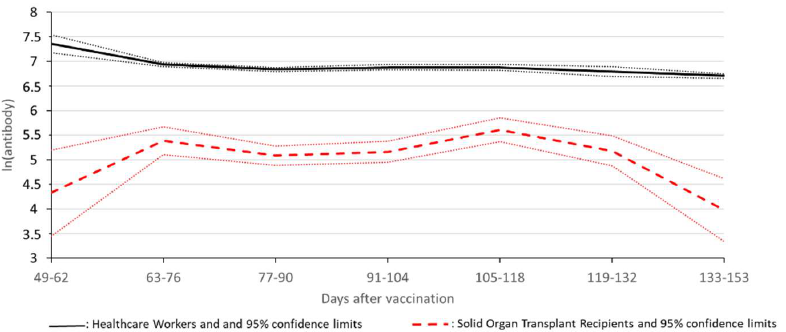
Figure 1. Mean ln (RBD) and 95% confidence limits in HCWs (continuous line) and SOT recipients (broken line) between 49 and 153 days after vaccination, adjusted for sex and age. The mean ln (AbR) in the two populations for the periods between 49 and 153 days after vaccination in individuals with positive AbR. The ratio of ln (AbR) between HCWs and SOT recipients ranged between 1.2 and 1.7, i.e., between 3.3 and 5.5 on arithmetic scale; SOT recipients showed a significant increase up to 76 days ( p < 0.001), then a non-significant decrease in ln (AbR) after 118 days ( p = 0.1); conversely, HCWs experienced a strong decrease in ln (AbR) up to 76 days ( p = 0.02), and a less pronounced decrease between 76 and 118 days ( p = 0.04).